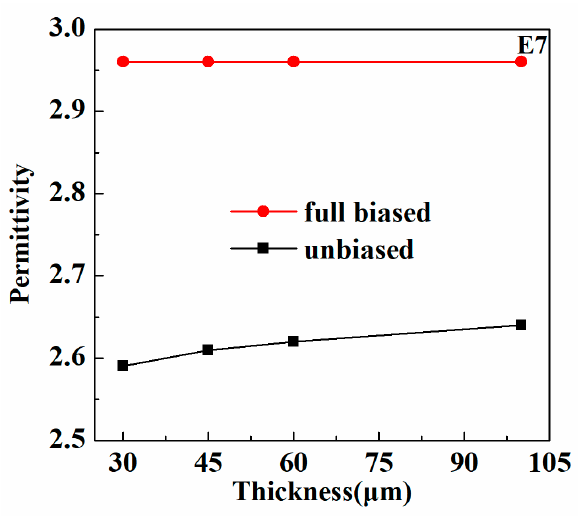
Figure 6. Permittivity as a function of the LC layer thickness for the LC E7 in the fully biased and unbiased states.